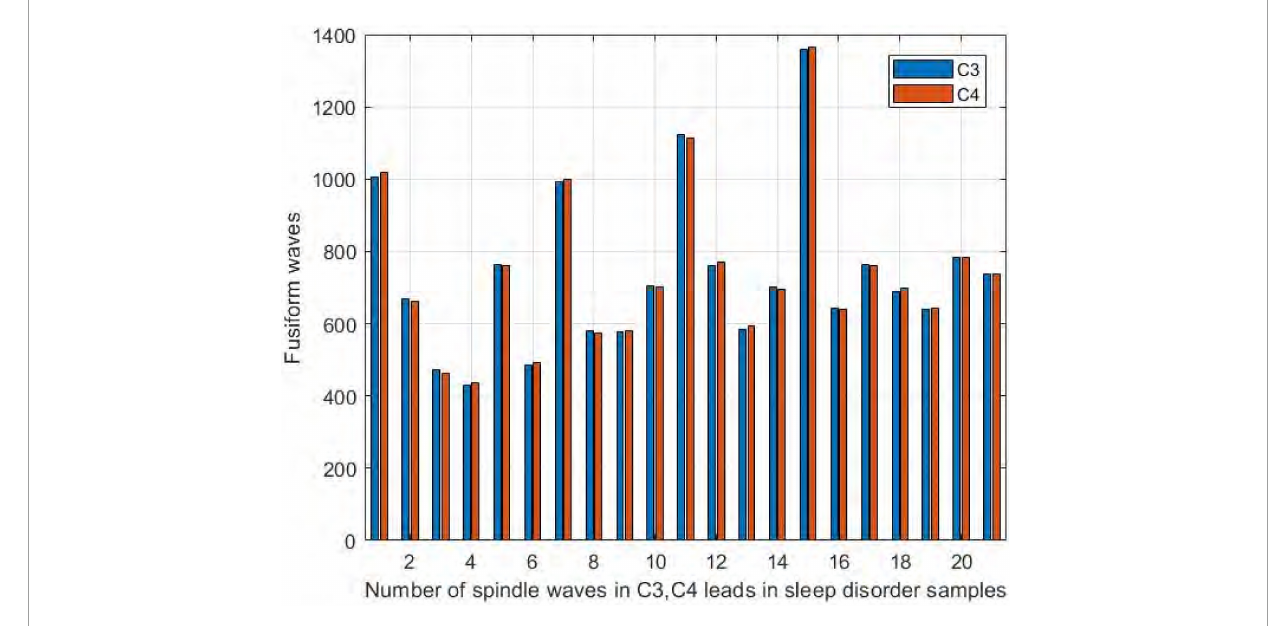
FIGURE10 Comparison of the number of spindles in C3 and C4 channels in the sleep-disordered population.